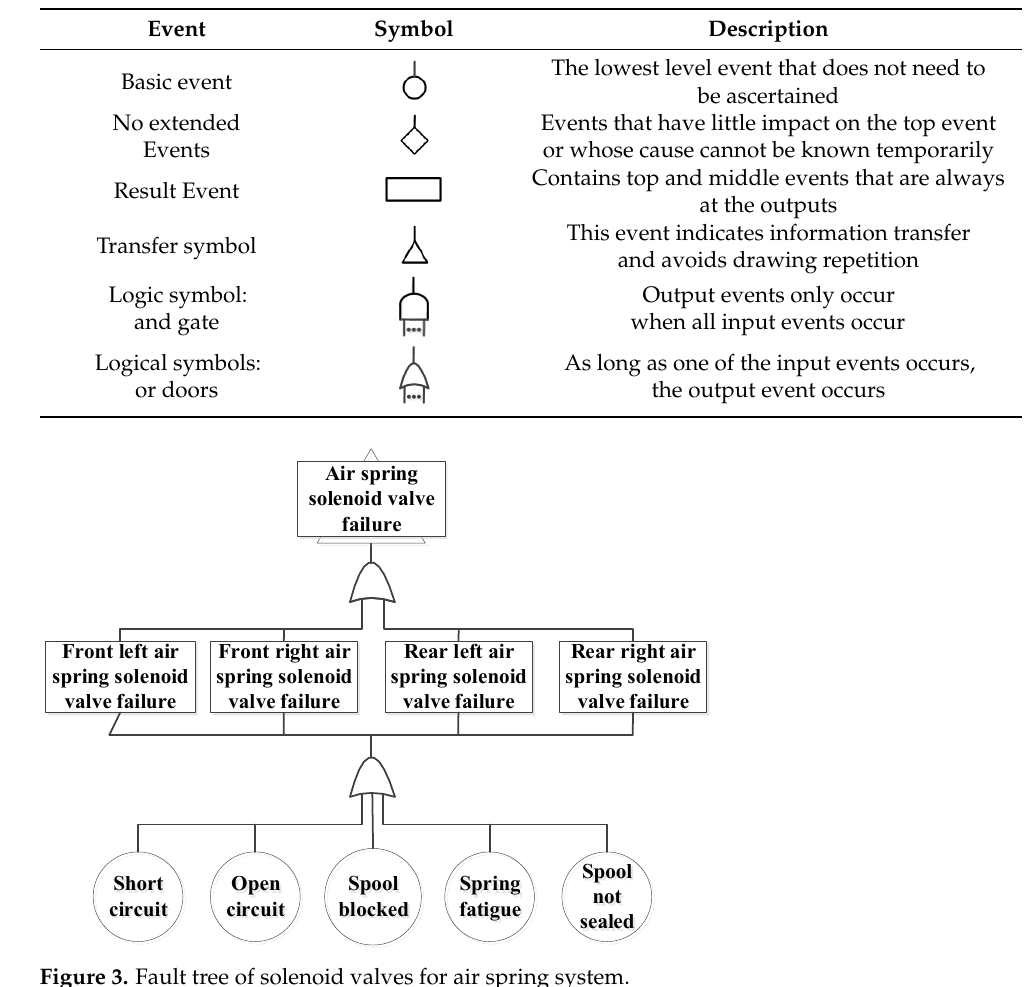
Table 1. Basic symbols and meanings of fault tree.